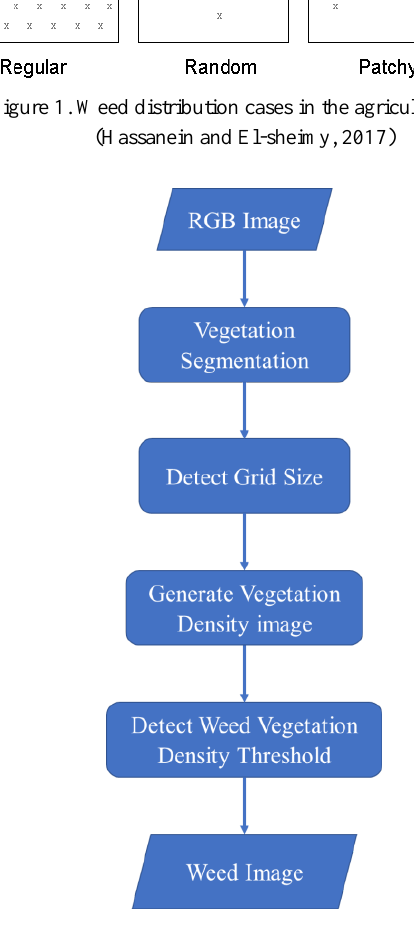
Figure 2. Proposed methodology